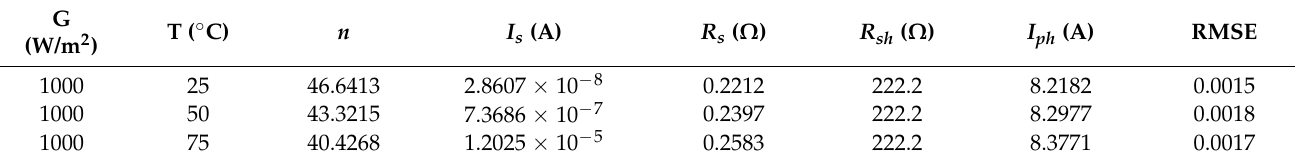
Table 4. Parameter-extraction results and RMSE for I- and P-V Curves in Figures 12 and 13.